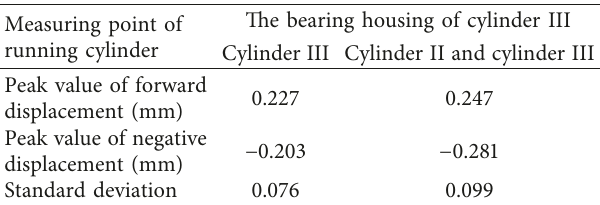
Figure 13: Vertical displacement of the bearing housing of cylinder III. (a) Time-vertical displacement curve. (b) Enlarged drawing. Table 7: Vertical vibration parameters of the bearing housing of cylinder